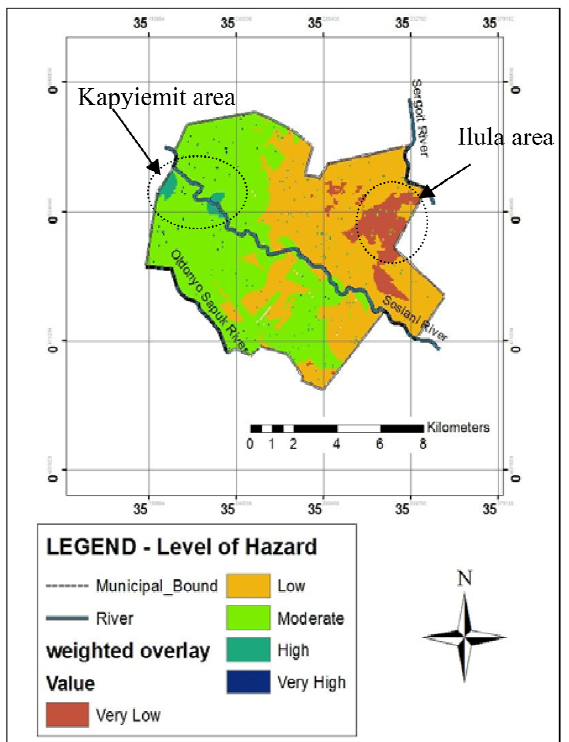
Figure 13. Flood hazard map of Eldoret Municipality under